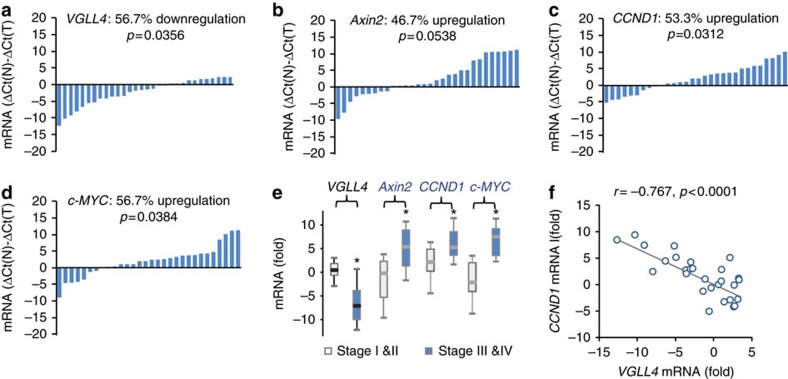
Downregulation of VGLL4 is associated with upregulation of Wnt target genes.(a) VGLL4 mRNA levels in CRC. Levels of VGLL4 mRNA in 30 paired human CRC and normal tissues were examined by real-time PCR, using GAPDH as an internal control. The value of each bar shows the difference between the VGLL4 mRNA level in normal tissue and that in the tumour, and is represented by the equation ΔCt(N)−ΔCt(T): a value>1 indicates that the VGLL4 mRNA level is increased in the tumours, and value<−1 indicates that the VGLL4 mRNA level is decreased in the tumours. Experiments were repeated two times. Paired t test was used to compare between paired tumour and normal tissues. (b–d) mRNA levels of Wnt target genes in CRC tissue. Relative mRNA levels of Axin2 (b), CCND1 (c) and c-MYC (d) were analysed. Experiments were repeated two times. Paired t tests were used. (e) Box plots of VGLL4 and Wnt target gene levels at different tumour stages. Data are expressed as median and interquartile range. Experiments were repeated two times. Unpaired t tests were used. *P<0.05, significant relative to control. (f) Scatter plot between VGLL4 and CCND1 mRNA levels in CRC samples. VGLL4 expression was compared with CCND1 by applying Spearman's correlation. Experiments were repeated two times (Supplementary Fig. 2).